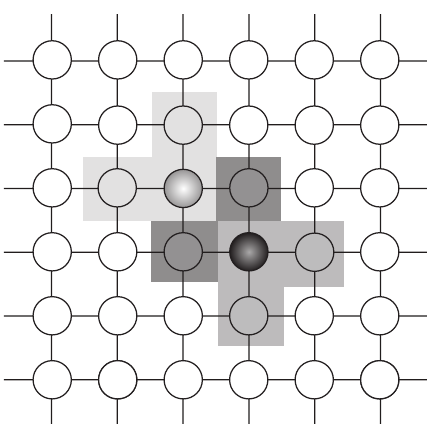
Figure 3: The population arrangement based on cellular structure where each cell is an individual in